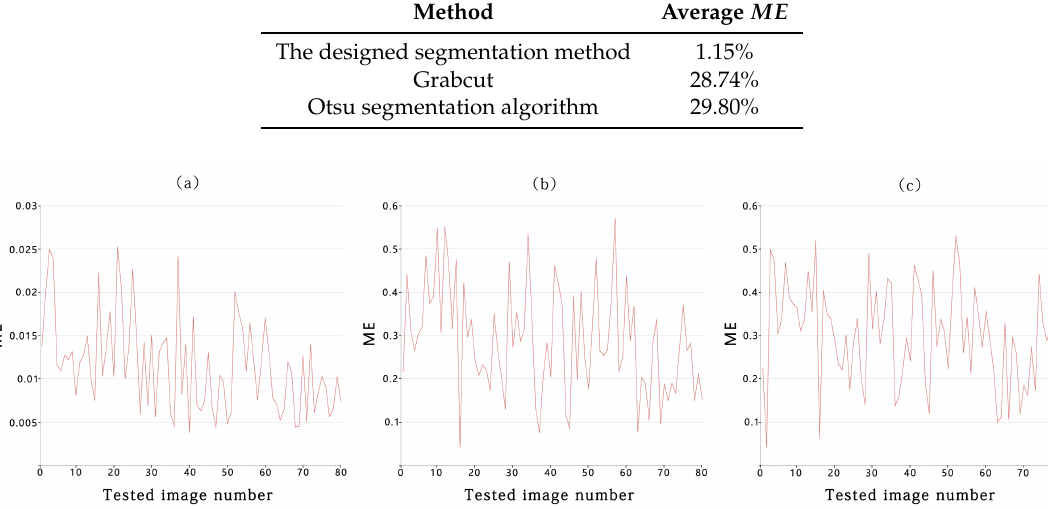
Figure 7. The ME of each image: ( a ) the designed segmentation method results, ( b ) Grabcut results, and ( c ) Otsu segmentation algorithm